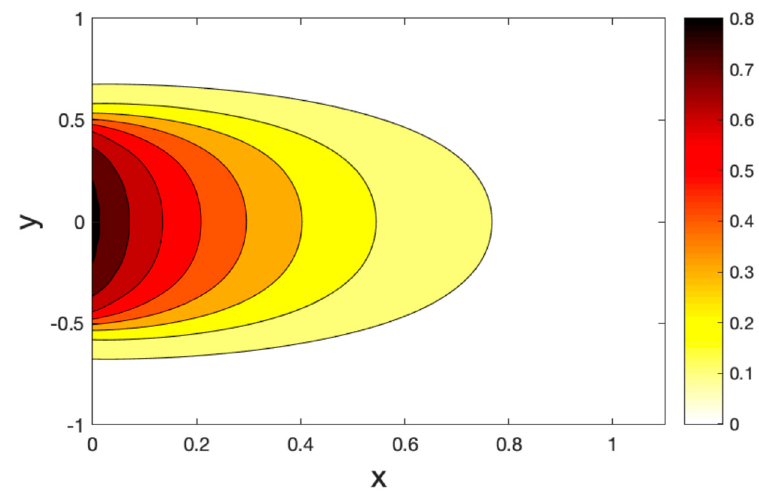
Figure 12. Contour plots of the temperature variations under the LS model.